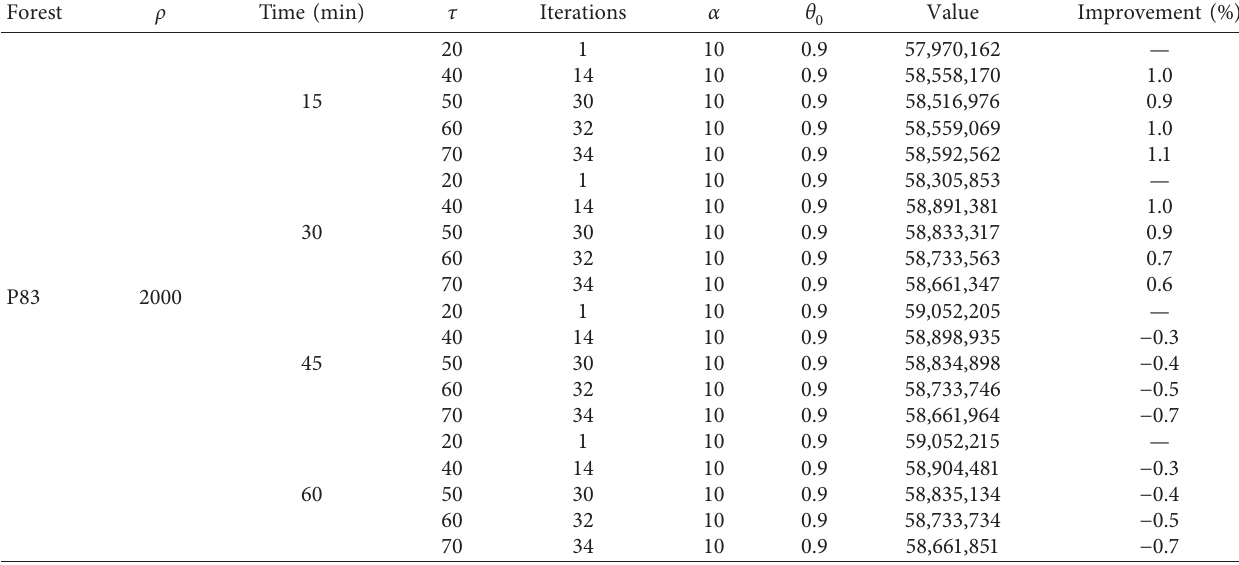
Table 8: Effects of τ and allocated time for the forest P83.